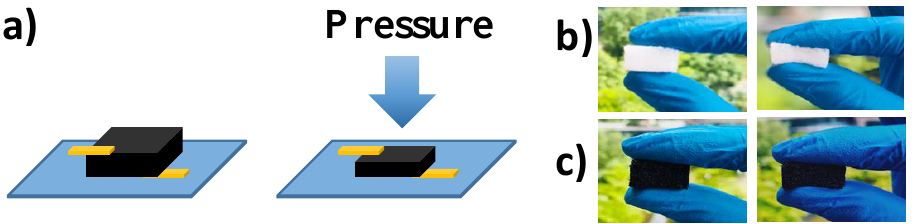
Figure 3. ( a ) Working principle schematic of the 3D porous piezoresistive sensor under external pressure; ( b ) photographs of the 3D porous structure layer of the pure PDMS sponge under relaxation (left) and compression (right); ( c ) photographs of the 3D porous dielectric layer of CB/MWCNTs/PDMS composites under relaxation (left) and compression (right).